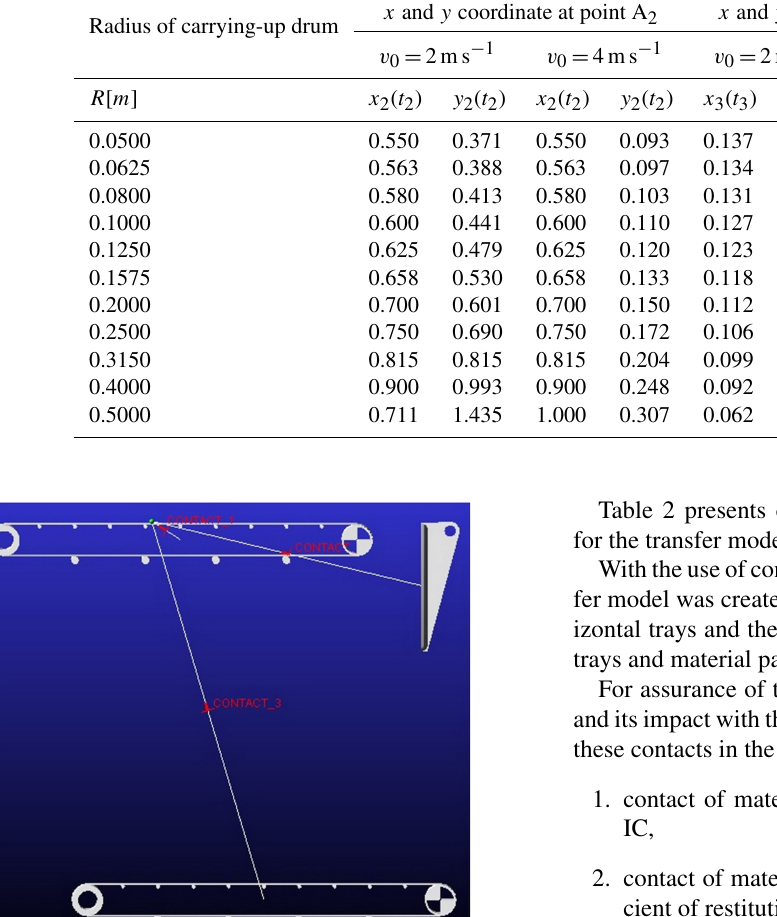
Table 1. Evaluation of coordinates [ x 2 , y 2 ] and [ x 3 , y 3 ] for velocities v 1 . Radius of carrying-up drum